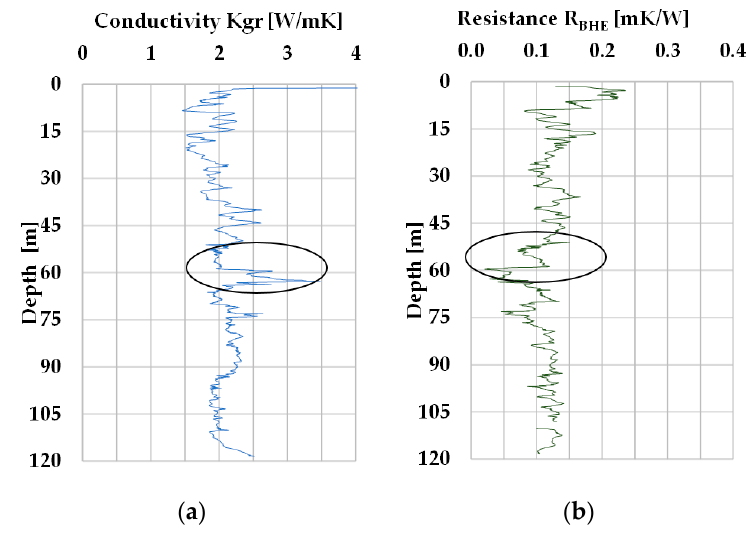
Figure 12. ( a ) Estimated conductivity k gr and ( b ) thermal resistance R bhe along the BHE depth as inferred from the ASC-1 measurements. The presence of peak values at the BHE mid depth (circles in figures) can be associated to the presence of groundwater circulation.